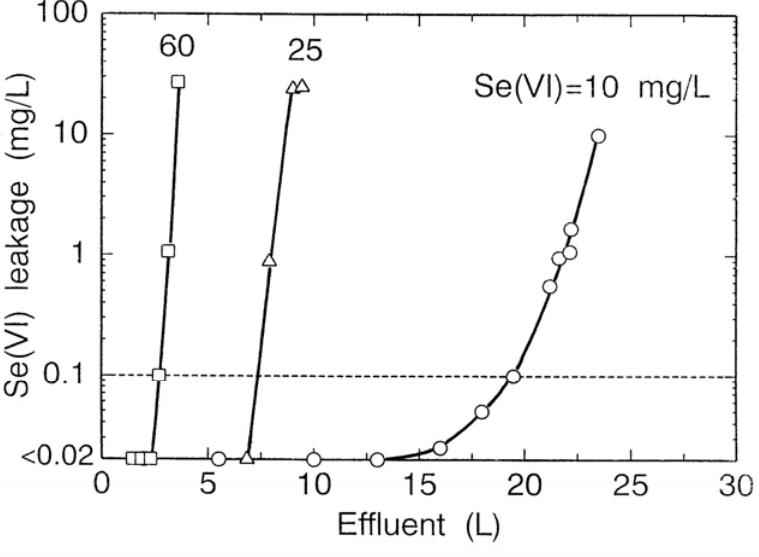
Figure 18. Breakthrough curves of selenium(VI) at different concentration of selenium(VI). pH = 6.0; bed volume of resin = 5.0 mL; SV =